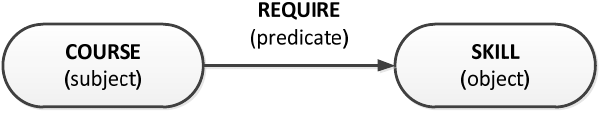
Figure 1. Triplet—the basic unit of semantic information representation.